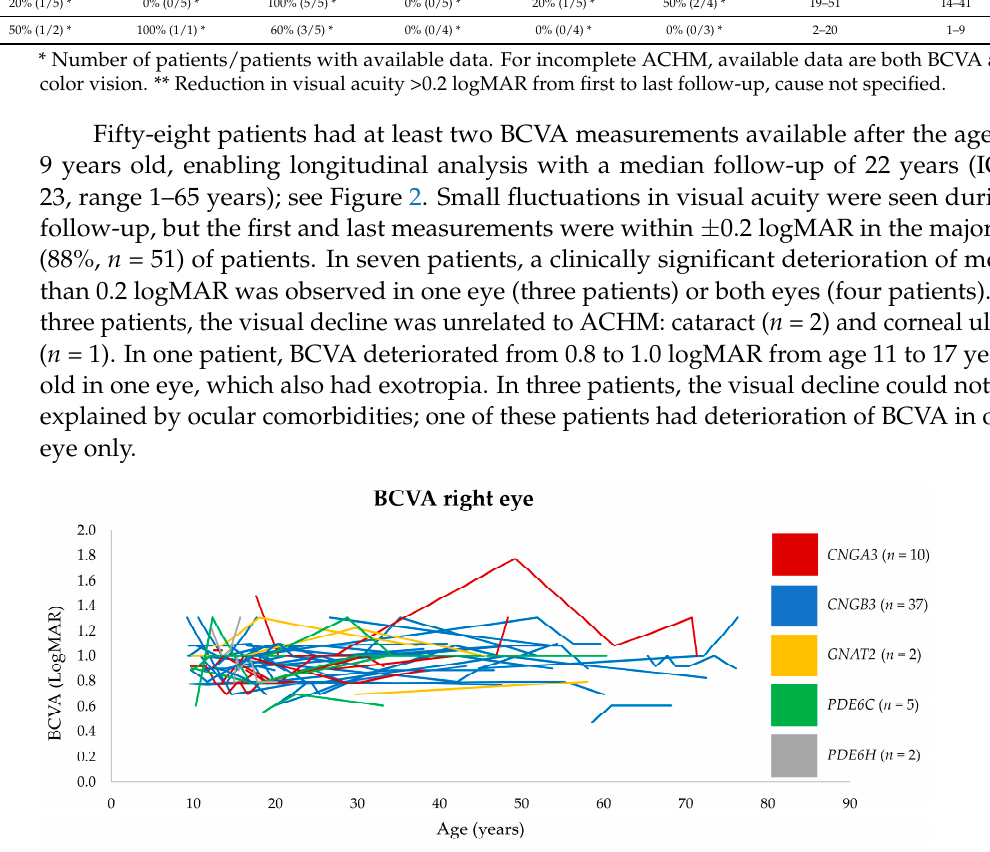
Table 1. Summary of clinical findings in all ACHM patients and in patients distributed according to specific causal genes.